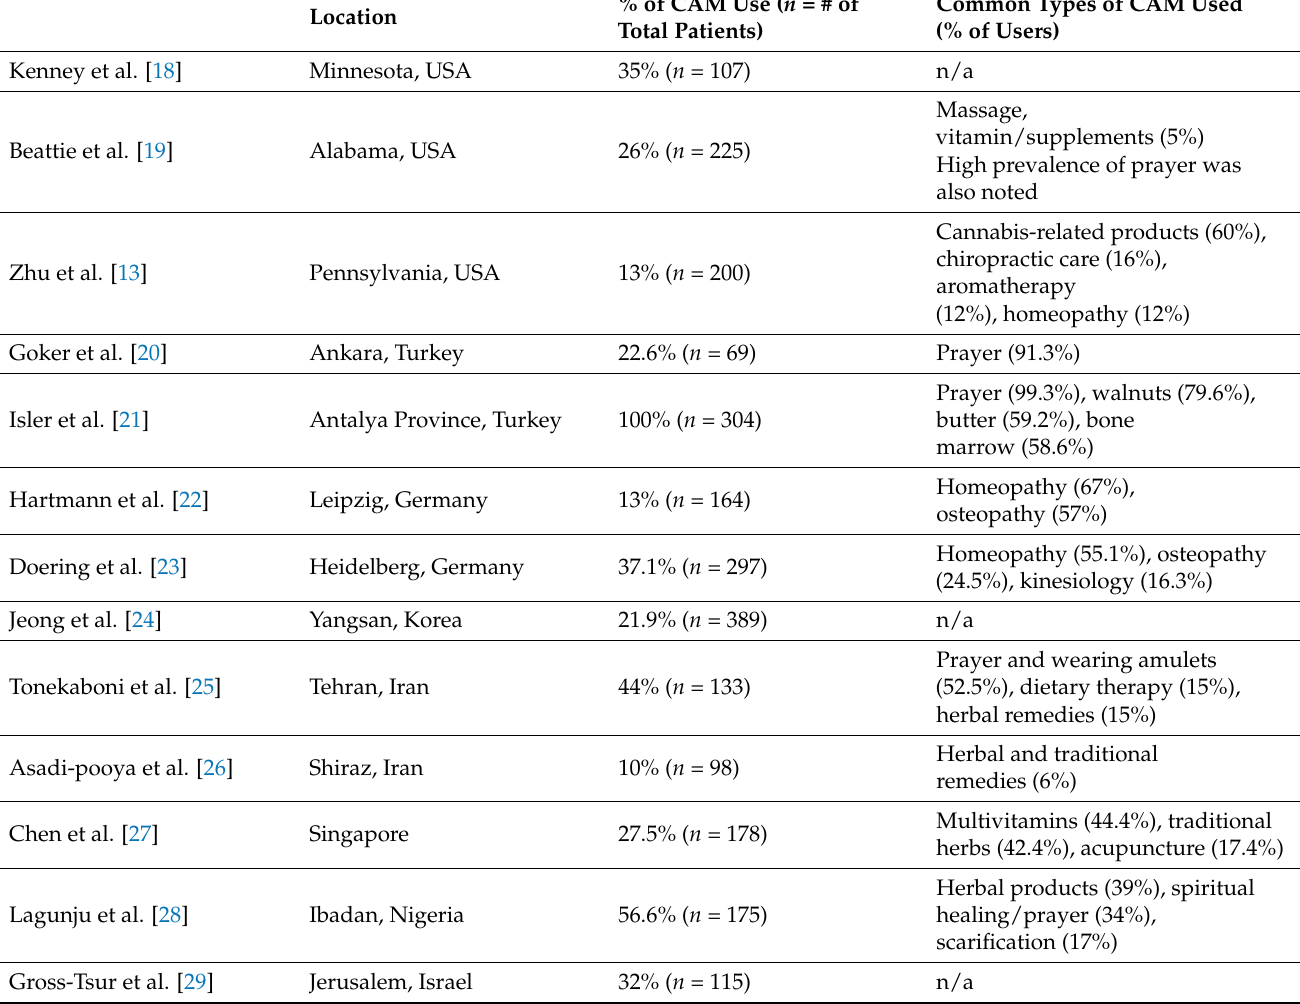
Table 1. Cross-sectional studies on CAM use among children with